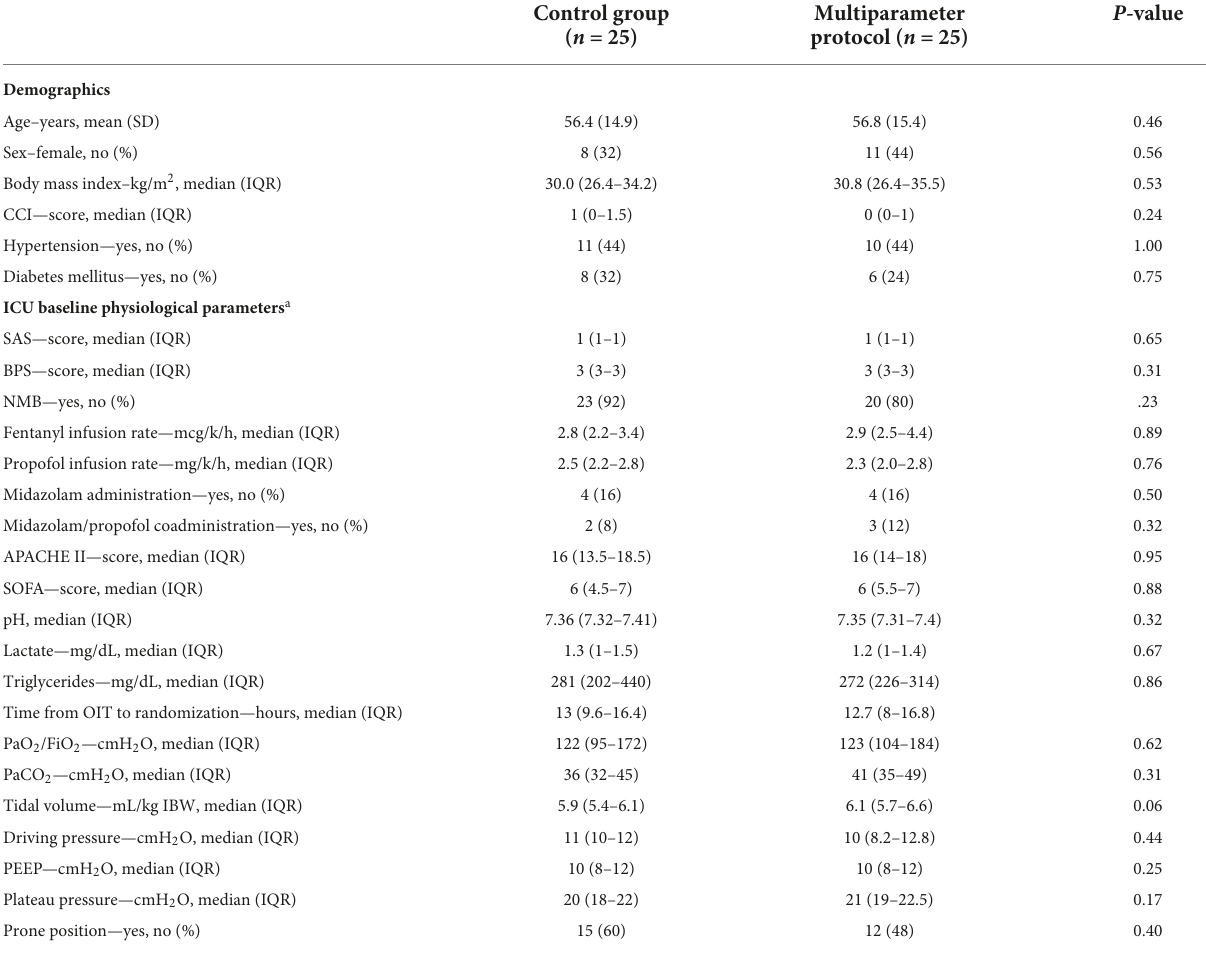
TABLE 1 Demographics and baseline physiological